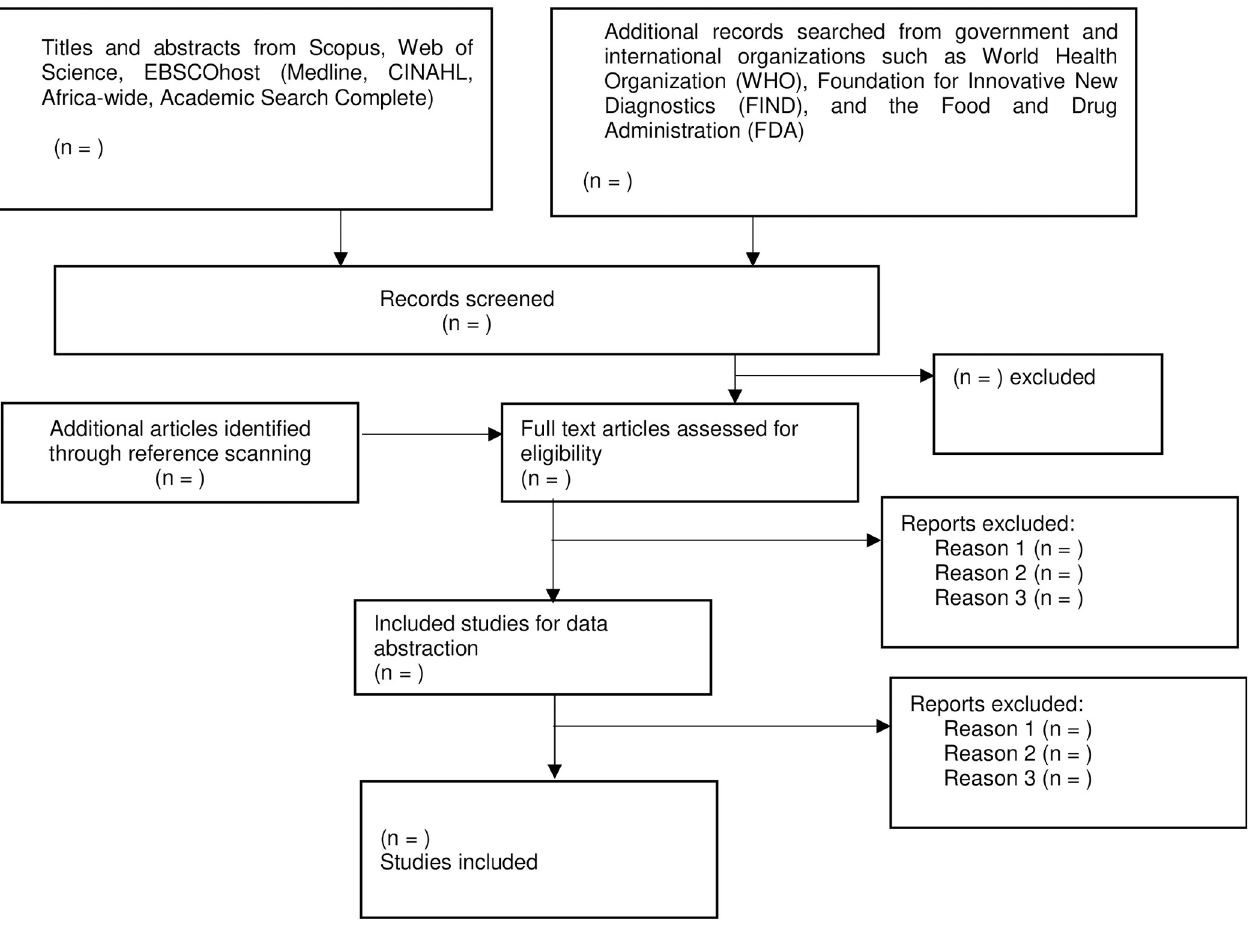
Fig 1. PRISMA-ScR flow